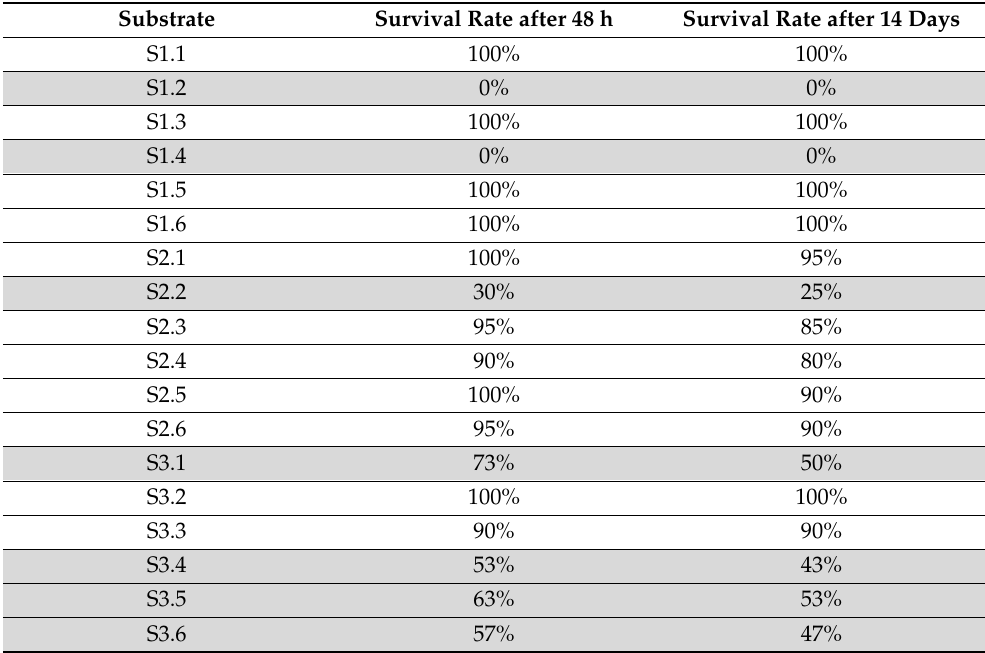
Table 4. Survival rate (%) of the earthworms Eisenia andrei exposed to tested substrates for 48 h and 14 days. Substrate Survival Rate after 48 h Survival Rate after 14 Days S1.1 100% 100% S1.2 0%